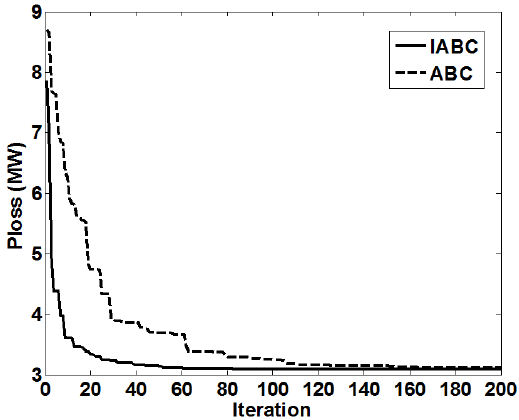
Figure 9. Convergence characteristics of power loss of the IABC and ABC algorithms for the IEEE 30-bus system.